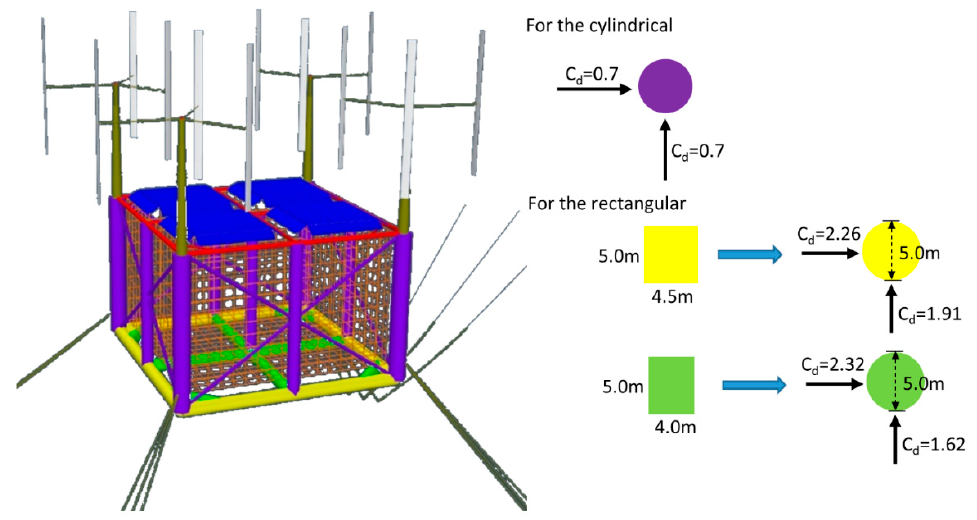
ffi cients for the parked condition of turbines. Figure 10. Numerical model and equivalent drag coefficients for the parked condition of turbines.